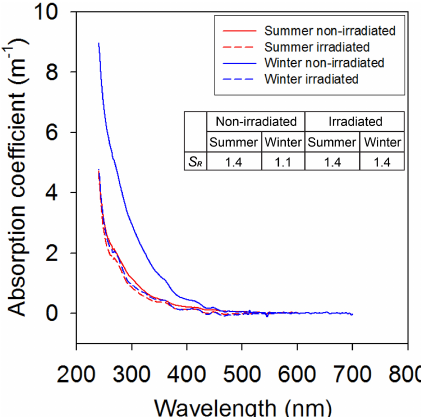
Figure 5. The absorption coefficients of the aerosol samples col- lected in the winter (30 December) (blue) and summer (14 August) (red) in 2015. The solid lines represent the initial values for the non- irradiated samples, and the dashed lines represent the final values for the irradiated